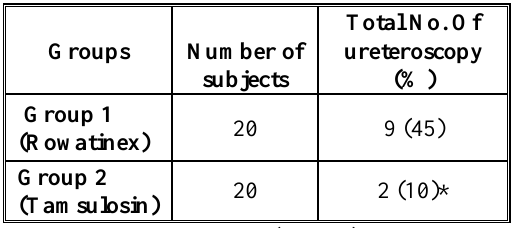
Table 4: Effect of treatment with rowatinex and tamsulosin on the total number of ureteroscopic procedures performed to remove the ureteral